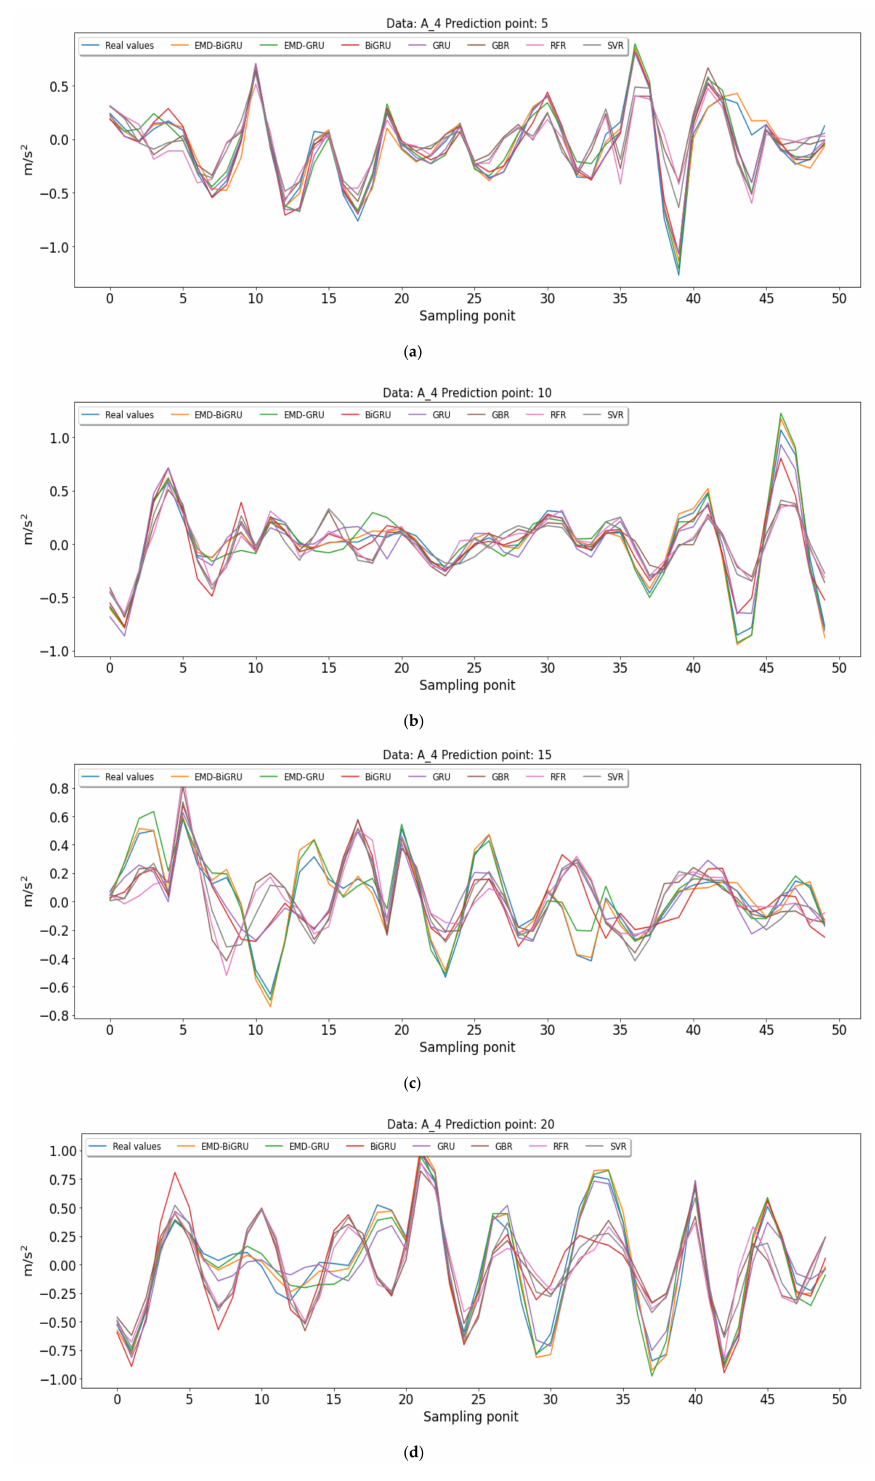
Figure A3. Comparisons results for different data sets using various algorithms. ( a ) Comparisons of predicted results for the A_4 data set using different algorithms (points 5). ( b ) Comparisons of predicted results for the A_4 data set using different algorithms (points 10). ( c ) Comparisons of predicted results for the A_4 data set using different algorithms (points 15). ( d ) Comparisons of predicted results for the A_4 data set using different algorithms (points